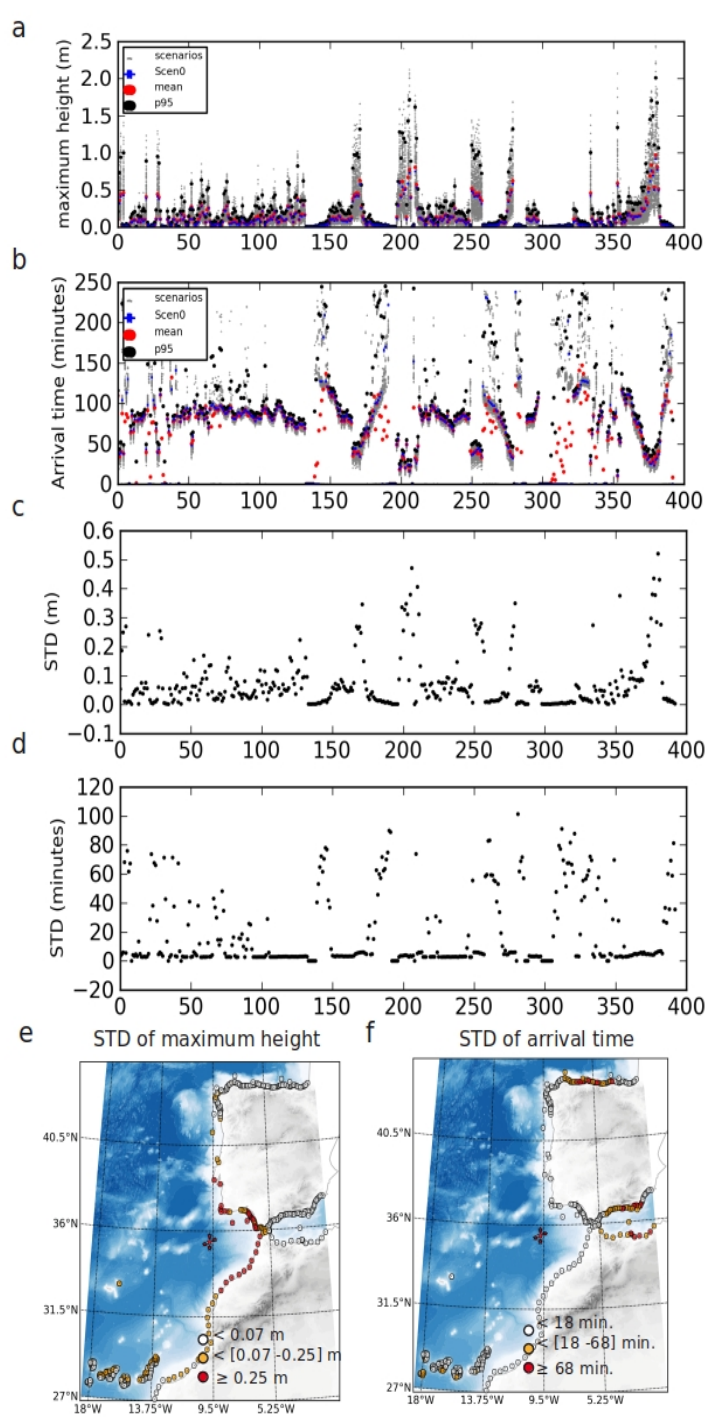
Figure 4. Synthetic results for all FCPs and scenarios: ( a ) for tsunami maximum height; ( b ) for tsunami arrival time. Scen0, in blue circles, denotes the results of the reference scenario, red circles the mean, and black triangles the value at the 95th percentile at each FCP. ( c , d ) black dots show standard deviation for every FCP for the tsunami maximum height and arrival time, respectively, ( e , f ) are maps of FCPs with color-coded mean standard deviation of tsunami maximum height and arrival time, respectively. Color-coded scale limits have been defined as the mean and 95th percentile of all the